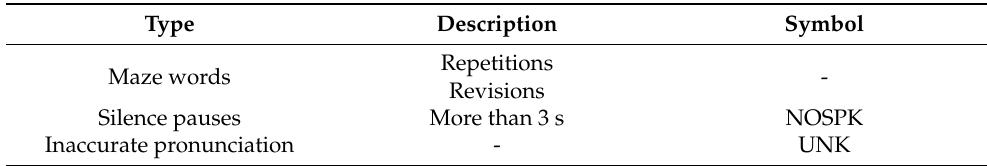
Table 3. Type of preprocessed vocabulary.